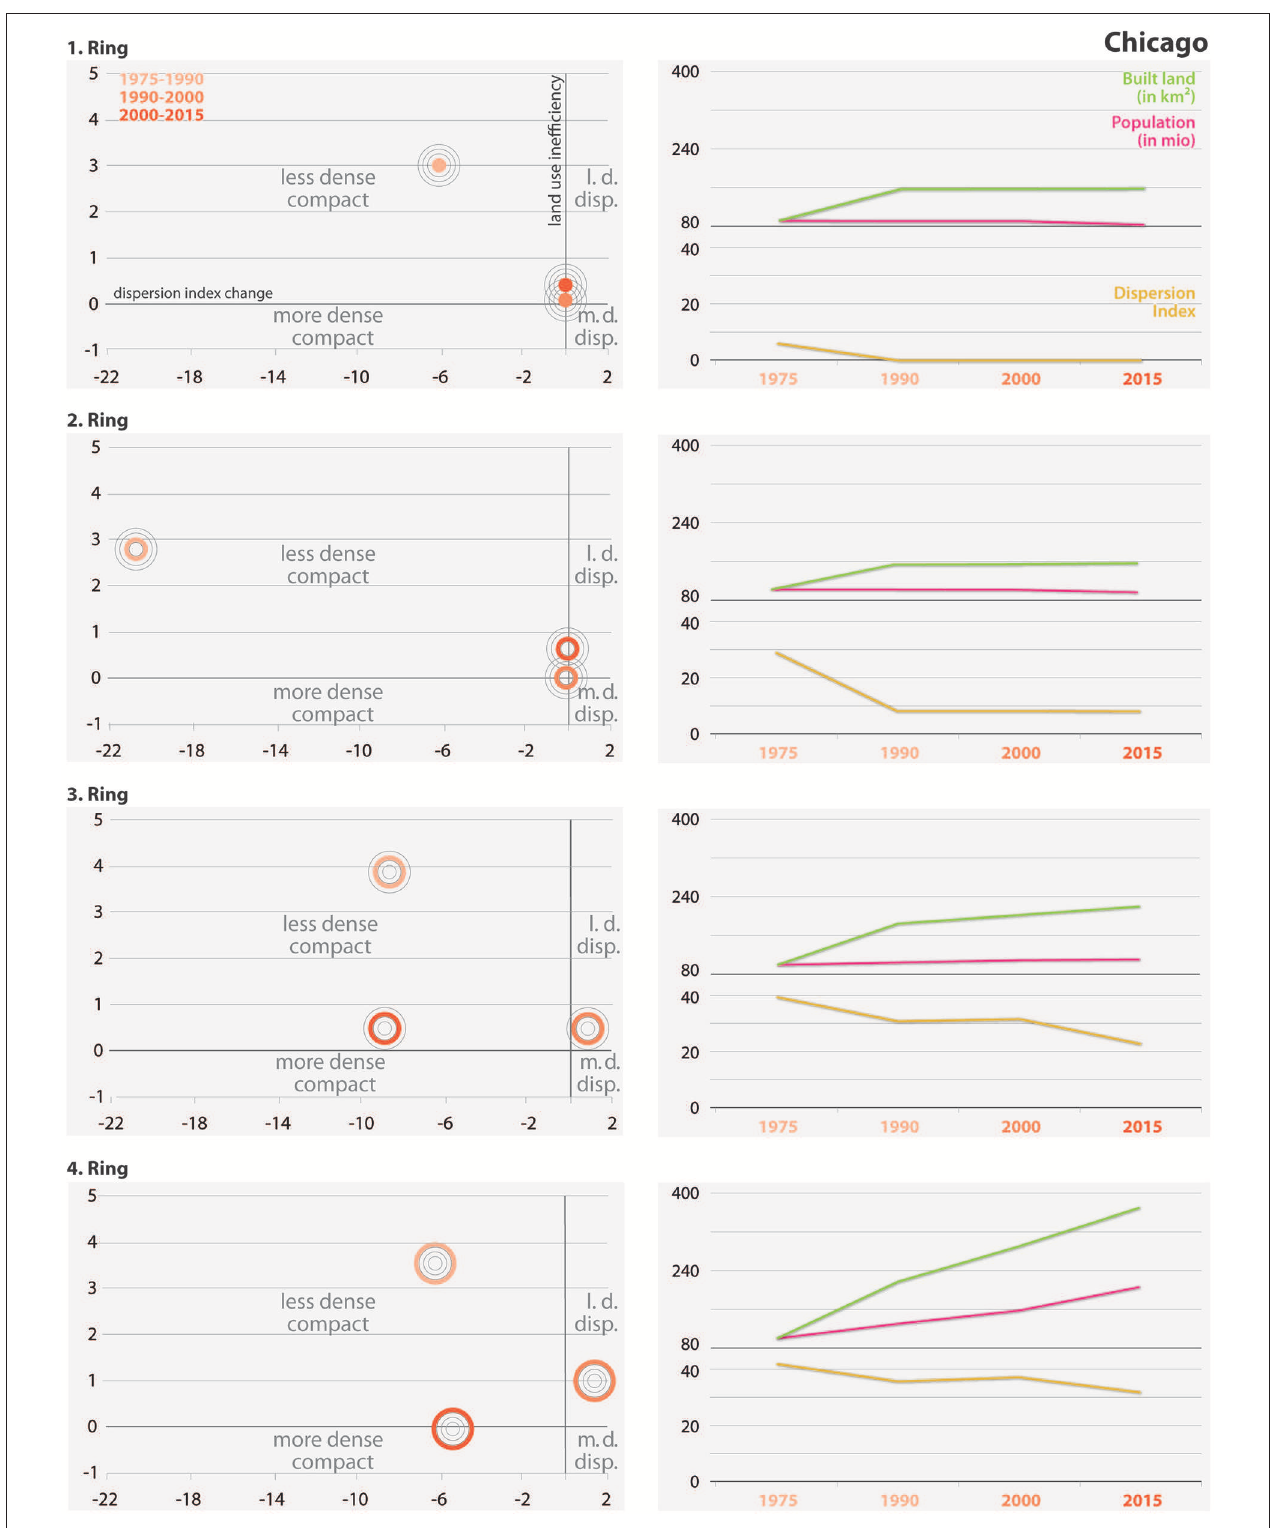
FIGURE 7 | Urbanization trends for Chicago divided into the four rings. The line charts illustrate the corresponding development of built-up land, population, and dispersion index over time.